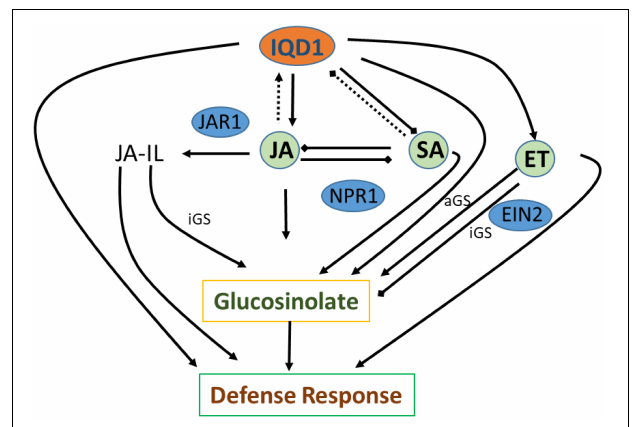
FIGURE 9 | Suggested model of IQD1 involvement in glucosinolate accumulation and defense responses. Intact arrows indicate positive connections ( → ), intact lines with diamond heads indicate negative connections ( → ), and dashed lines indicate effects on expression (.....). JA-Il, jasmonic acid isoleucine; aGS, aliphatic glucosinolate; iGS, indolic glucosinolate; JAR1, JASMONATE RESISTANT 1; NPR1, NON-EXPRESSER OF PR GENES1; EIN2, ETHYLENE INSENSITVE